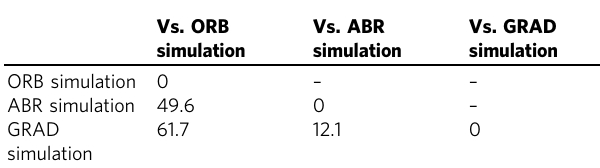
Table 1 BIC difference Δ BICij = BICj – BICi for the ORB, GRAD and ABR